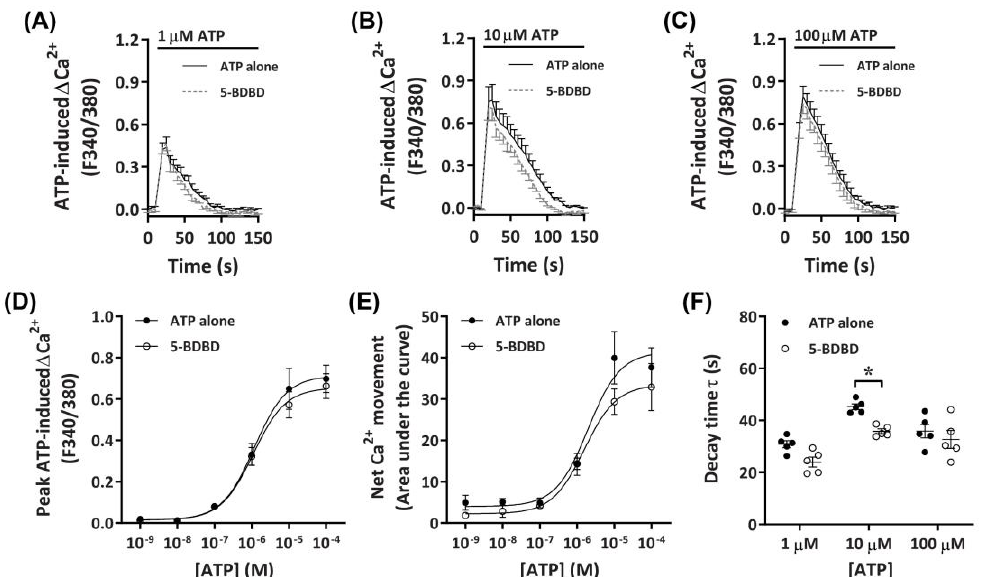
Figure 5. ATP-induced Ca 2+ responses in DH82 cells in the absence or presence of 5-BDBD. ( A – F ) DH82 cells in ECS were loaded with Fura-2 and preincubated in the absence (ATP alone) or presence of 30 µM 5-BDBD (both 0.3% DMSO) for 5 min. Cells were then exposed to increasing concentrations of ATP and Fura-2 fluorescence was recorded. ( A – C ) ATP-induced Ca 2+ traces (F340/380) were plotted and the ( D ) peak Ca 2+ response and ( E ) net Ca 2+ movement were fit to the Hill equation to produce concentration-response curves. ( F ) One phase decay time ( τ ) calculated from the peak of each Ca 2 + trace in ( A – C ). ( A – F ) Data shown are mean ± SEM from five independent experiments. ( D – F ) * p < 0.05 compared to respective concentration of ATP alone analysed using a two-way ANOVA with Bonferroni post hoc test.